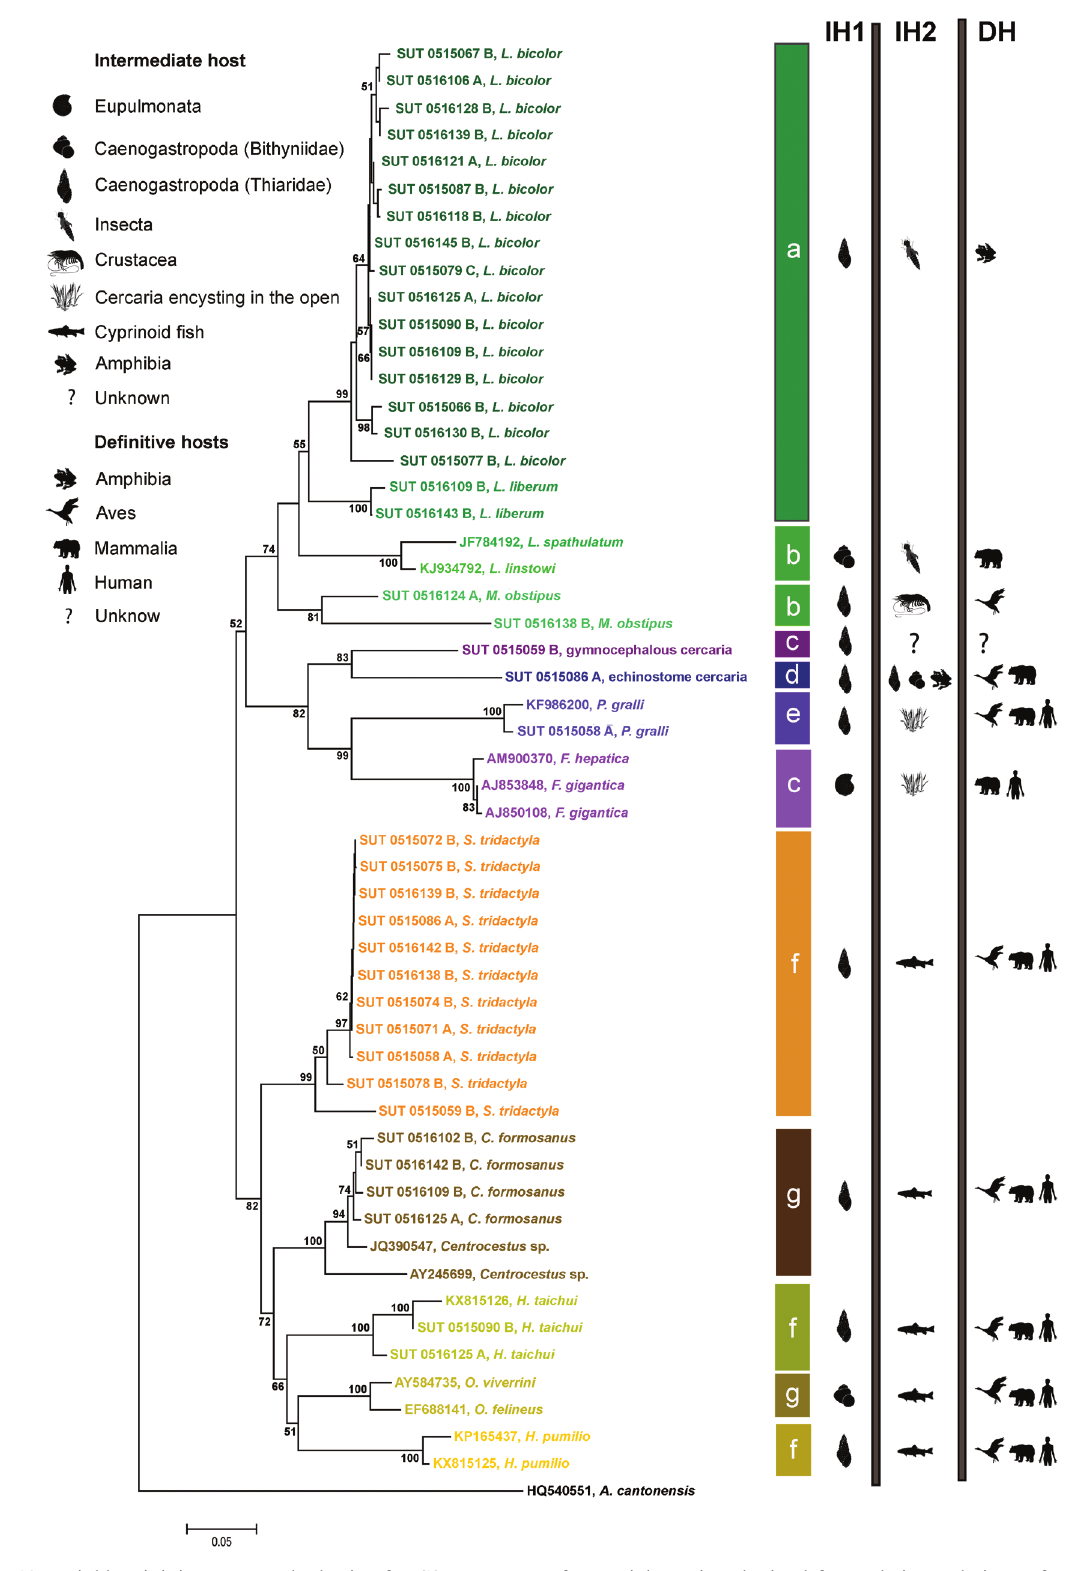
Figure 18. Neighbor-joining tree on the basis of ITS2 sequences of cercarial species obtained from Thai populations of Tarebia granifera (Lamarck, 1816) and several published sequences obtained from GenBank. Nodes are annotated with bootstrap support values ≥ 50. Taxon names and voucher or GenBank accession numbers are provided at the tips of the tree (see also Table 1). First and second intermediate hosts and definitive hosts are indicated (see legend). Abbreviations – DH: definitive host: IH1: first intermediate host; IH2: second intermediate host. Cercarial types – a : virgulate xiphidiocercariae; b : armatae xiphidiocercariae; c : gymnocepha- lous cercariae; d : echinostome cercariae; e : megarulous cercariae; f : parapleurophocercous cercariae; g : pleurophocercous